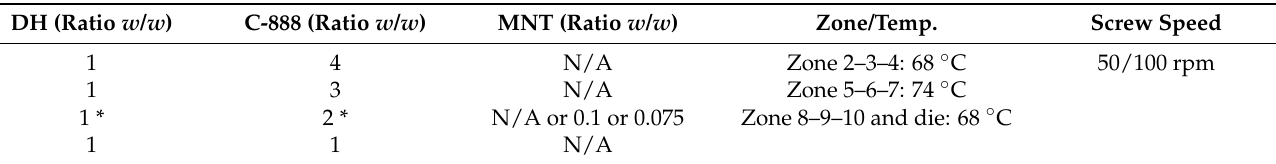
Table 1. Formulation compositions and processing parameters for lipid carrier. DH: donepezil hydrochloride; C-888: Compritol ® 888 ATO; MNT: mannitol.